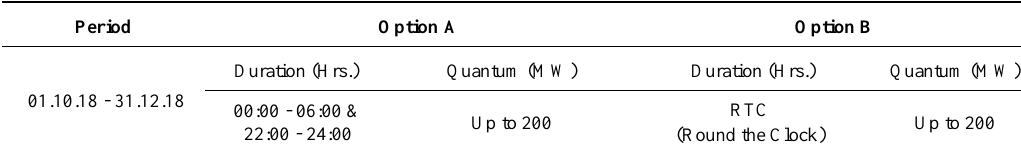
Table 2. Return cycle of power from Utility B to Utility